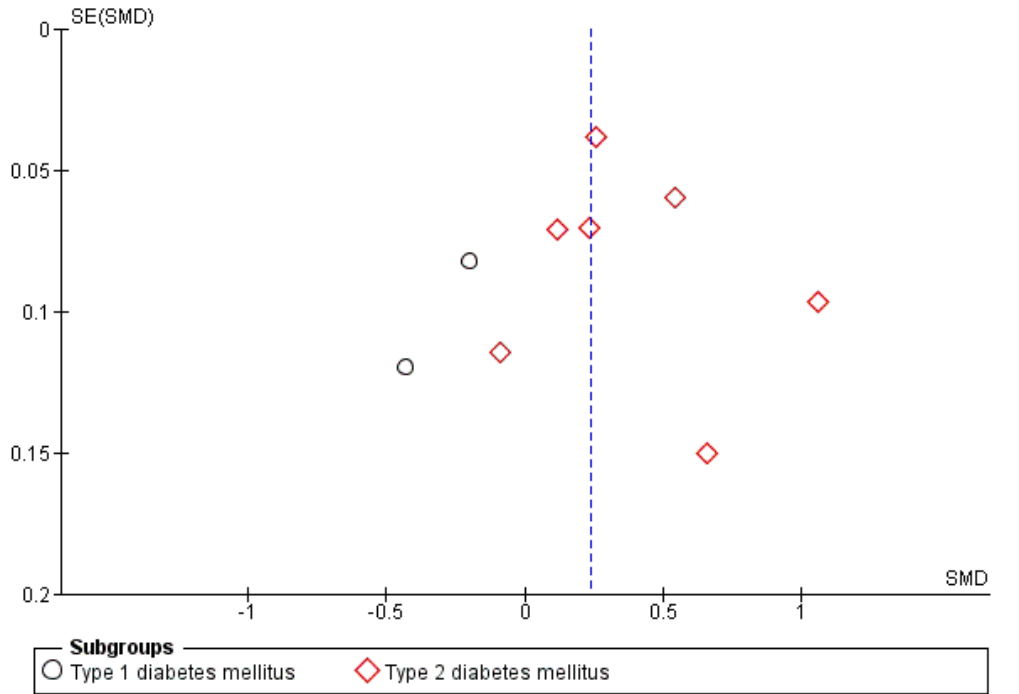
Figure 7. Funnel plot of the results from studies assessing the neuropathy prevalence in diabetic patients with NAFLD. SE: standard error, SMD: standardized mean difference.